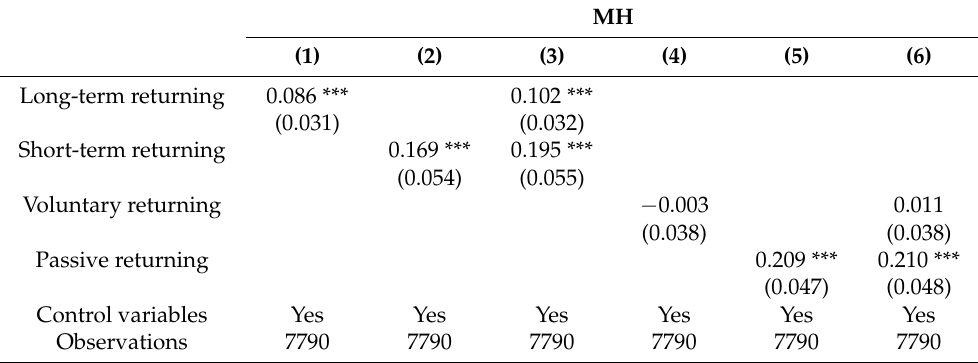
Table 7. Heterogeneous Effects: different types of returning.